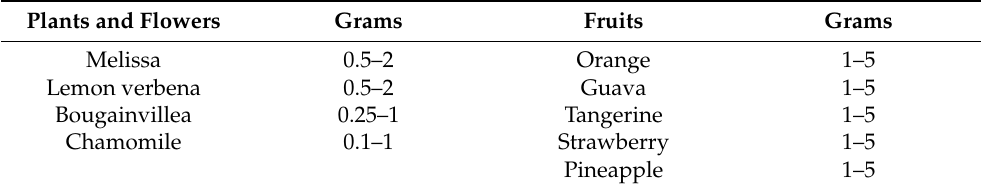
Table 1. Proportion of each ingredient (grams dw/240 mL) used in the formulation of the devel- oped